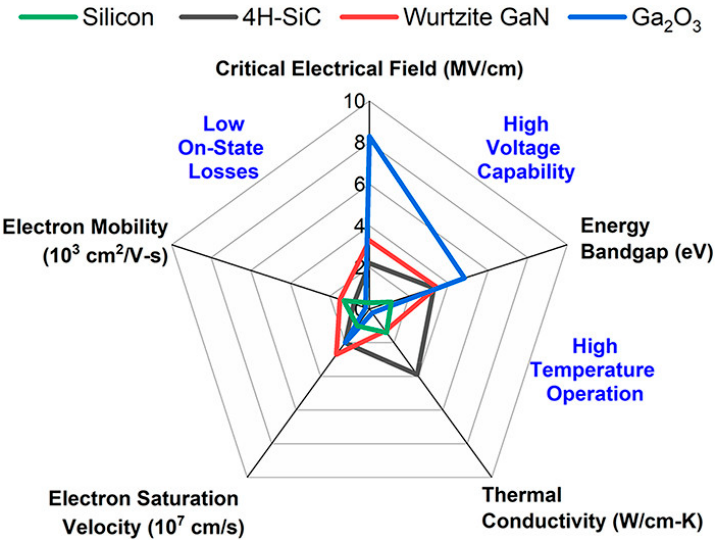
2 of 19 Table 1. Material properties of various WBG semiconductors and β -Ga 2 O 3. Si